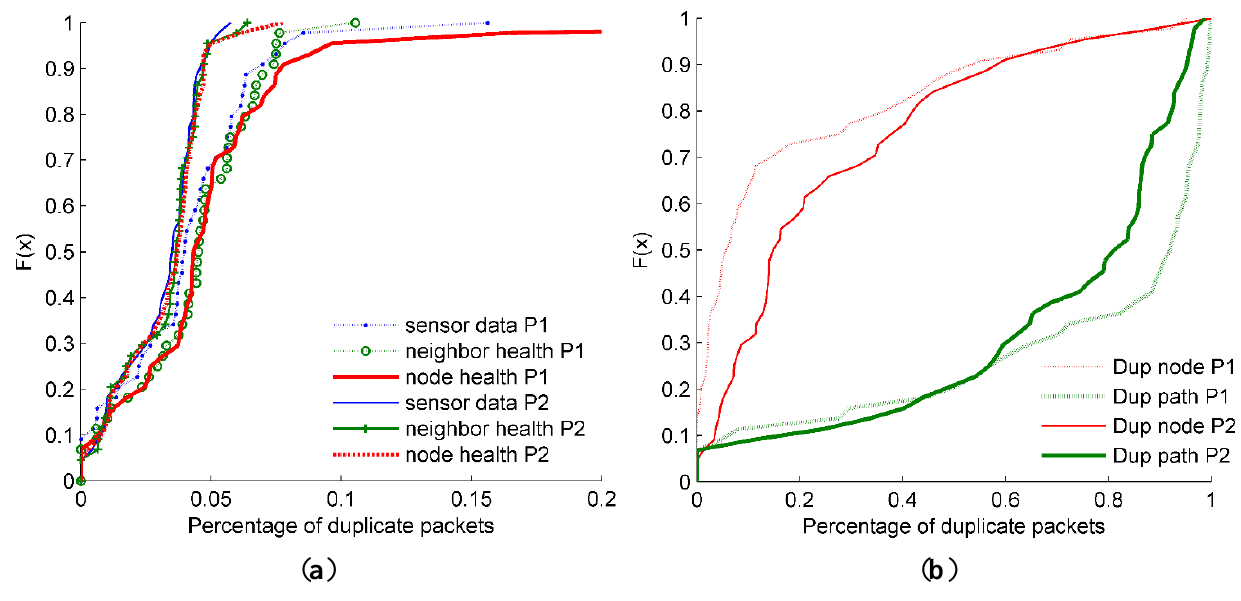
Figure 5. ( a ) CDF percentage of duplicate packets received per node for each packet type; ( b ) CDF percentage of each duplicate packet type: duplicates at the origin node and duplicates along the